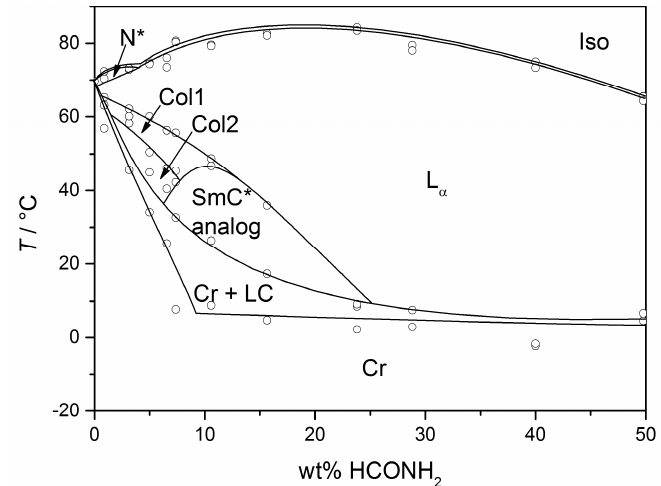
Figure 15. Phase diagram of the system 4 / formamide measured in heating. Next to the lyotropic SmC* phase (SmC* analog), a cholesteric (N*), two columnar (Col1, Col2) and a rather pronounced lamellar L α phase occur. (Reprinted by with permission from Springer Nature: [13].)